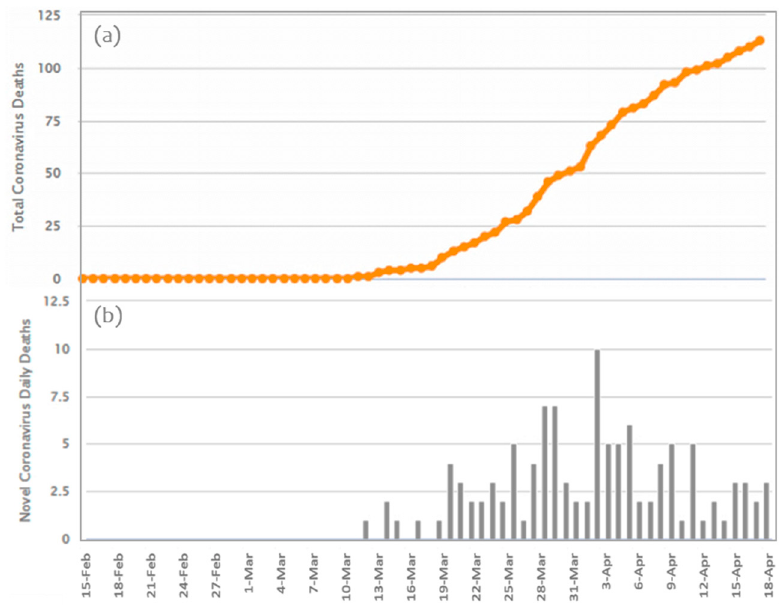
Figure 3. The time ‐ series of the COVID ‐ 19 death curve in Greece for the period 15 February 2020–18 April 2020. The first death was recorded on 12 March 2020 (data source: [15]). ( a ) Total Coronavirus Deaths; ( b ) Novel Coronavirus Dairy Deaths.